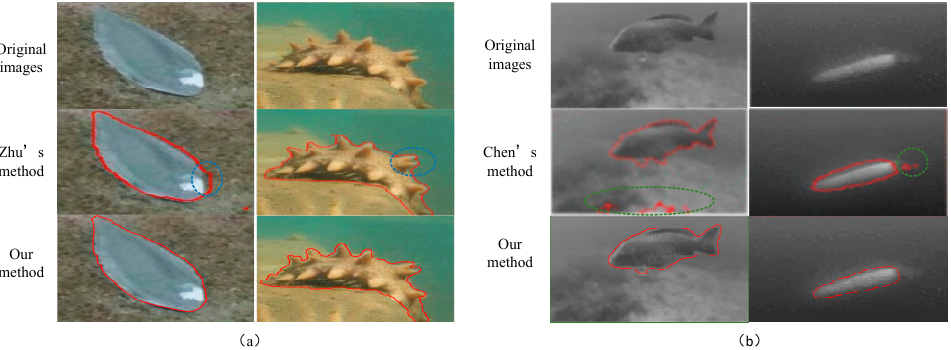
Figure 6. Comparison of our method with Zhu’s method and Chen’s method [20]. ( a ) Comparison of our method with Zhu’s method. ( b ) Comparison of our method with Chen’s method. The first row is the original underwater images; the second row is the segmentation results in Zhu’s method [15] and Chen’s method [20]. The third row shows the results of our method.